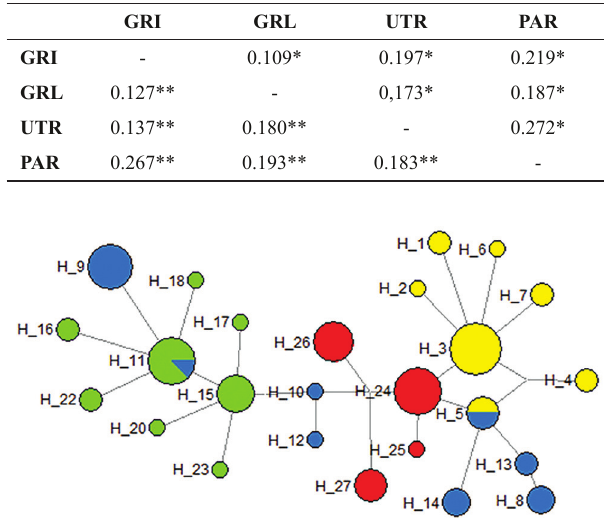
indices between parenthesis Table 3. Pairwise D EST (below diagonal) using microsatellites and mtDNA (above diagonal) between four Salminus hillari samples. Statistical significance of Φ value was tested based on the exact test ST based on 10,000 permutations, * P < 0.05, ** P < 0.01.